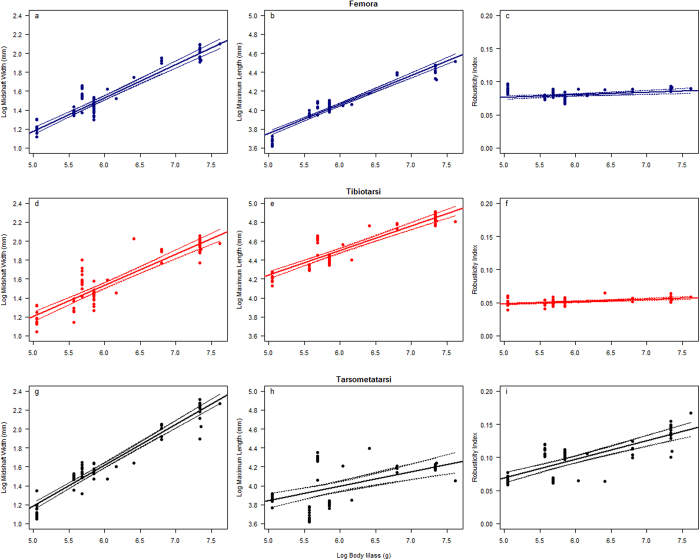
Strigiform hind limb dimensions plotted against log body mass (g).Plots show variation in midshaft width (a,d,g), maximum length (b,e,h) and robusticity index (c,f,i) for the femora (a–c), tibiotarsus (d–f), and tarsometatarsus (g–i). Dotted lines indicate 95% confidence intervals.